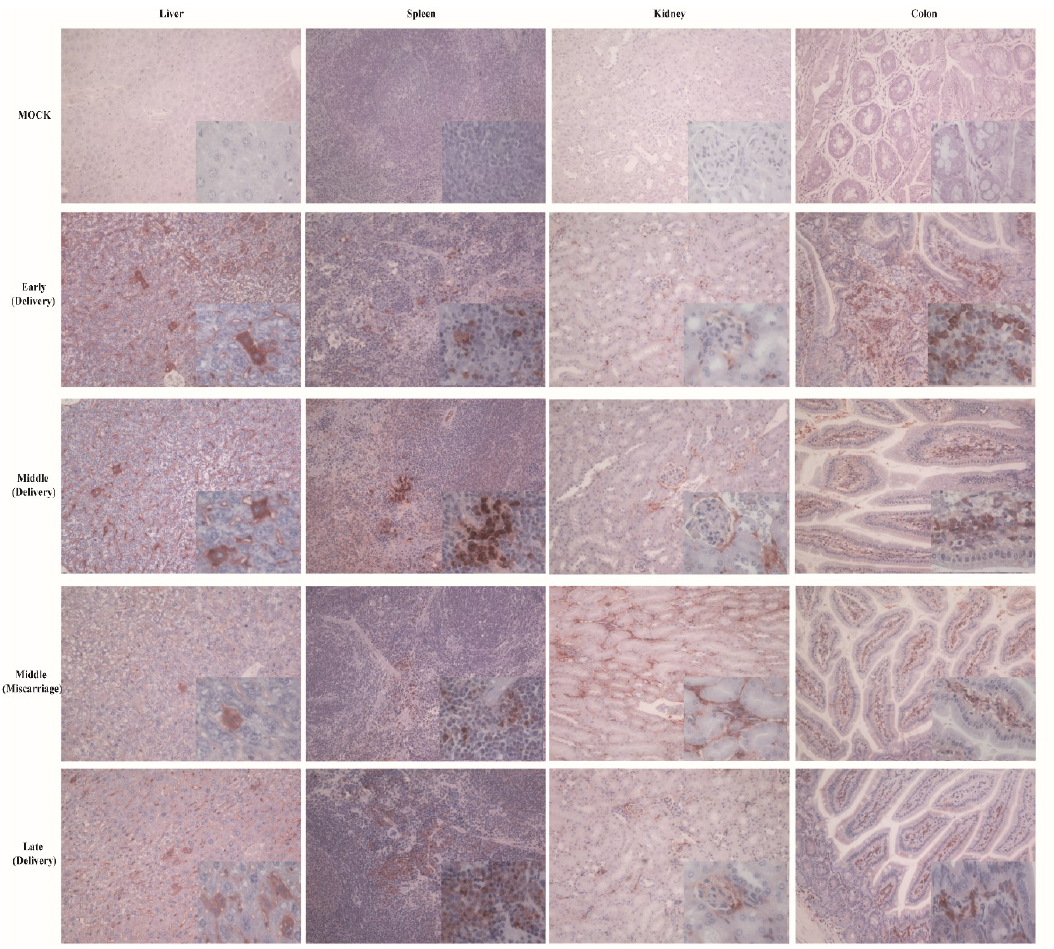
Figure 3. HEV antigens detected by IHC. HEV antigens detected in the liver, spleen, kidney and colon of mice infected with or without HEV, ×